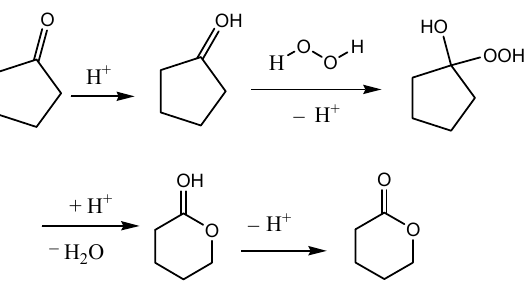
Figure 9. A possible mechanism for Baeyer–Villiger oxidation over Bronsted acid [75].